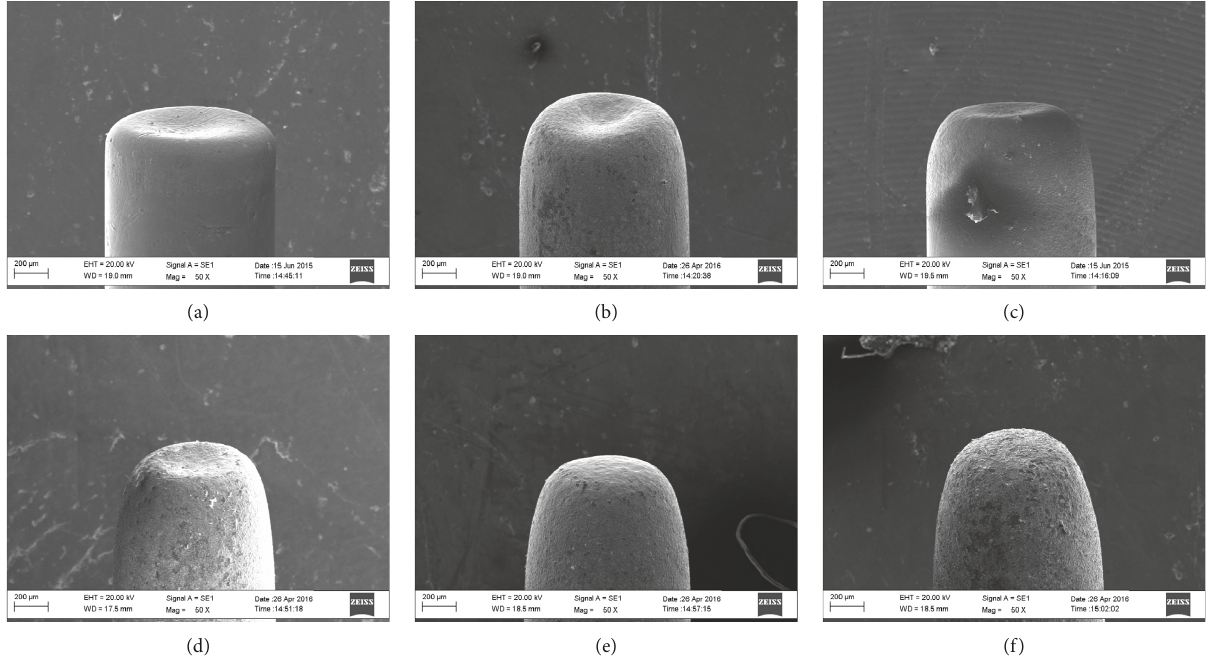
Figure 13: Electrode shape change with increasing peak current (no. 6 of Table 1). (a) 3.4A. (b) 9.4A. (c) 15.4 A. (d) 21.4A. (e) 27.4A. (f)